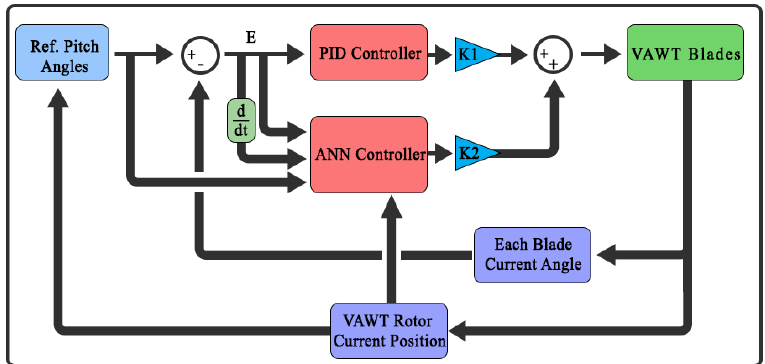
Figure 8. A block diagram of the blade pitch control system for one blade.